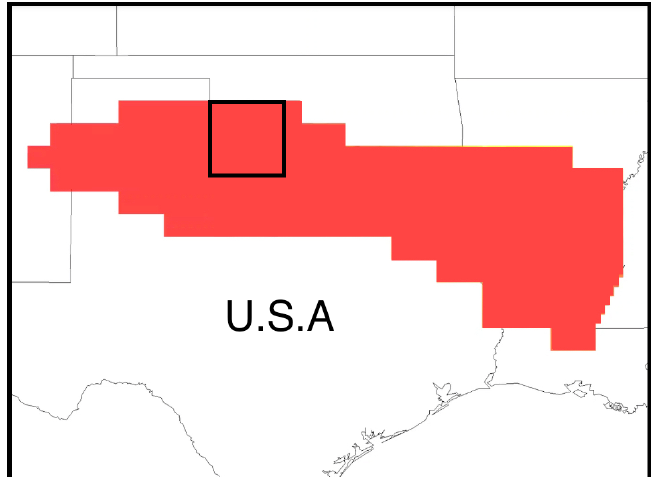
Figure 1. Gridded spatial mask of the Red River Basin (United States of America). Spatial resolution 1/10th degree. Black square indicates the study area.